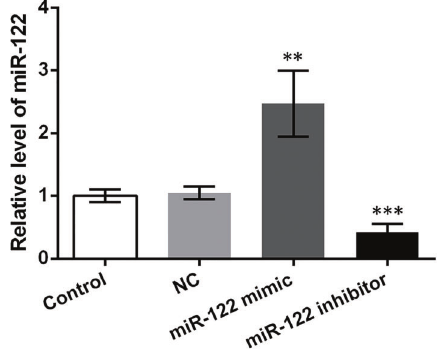
Figure 1. Levels of miR-122 in transfected mouse cardiomyo- cytes. Mouse cardiomyocytes were transfected with miR-122 mimic, miR-122 inhibitor or the negative control (NC). qRT-PCR was performed at 48-h post-transfection to quantify miR-122. Control: untransfected cells. Data are reported as means ± SD. **P o 0.01, ***P o 0.001 compared to NC group